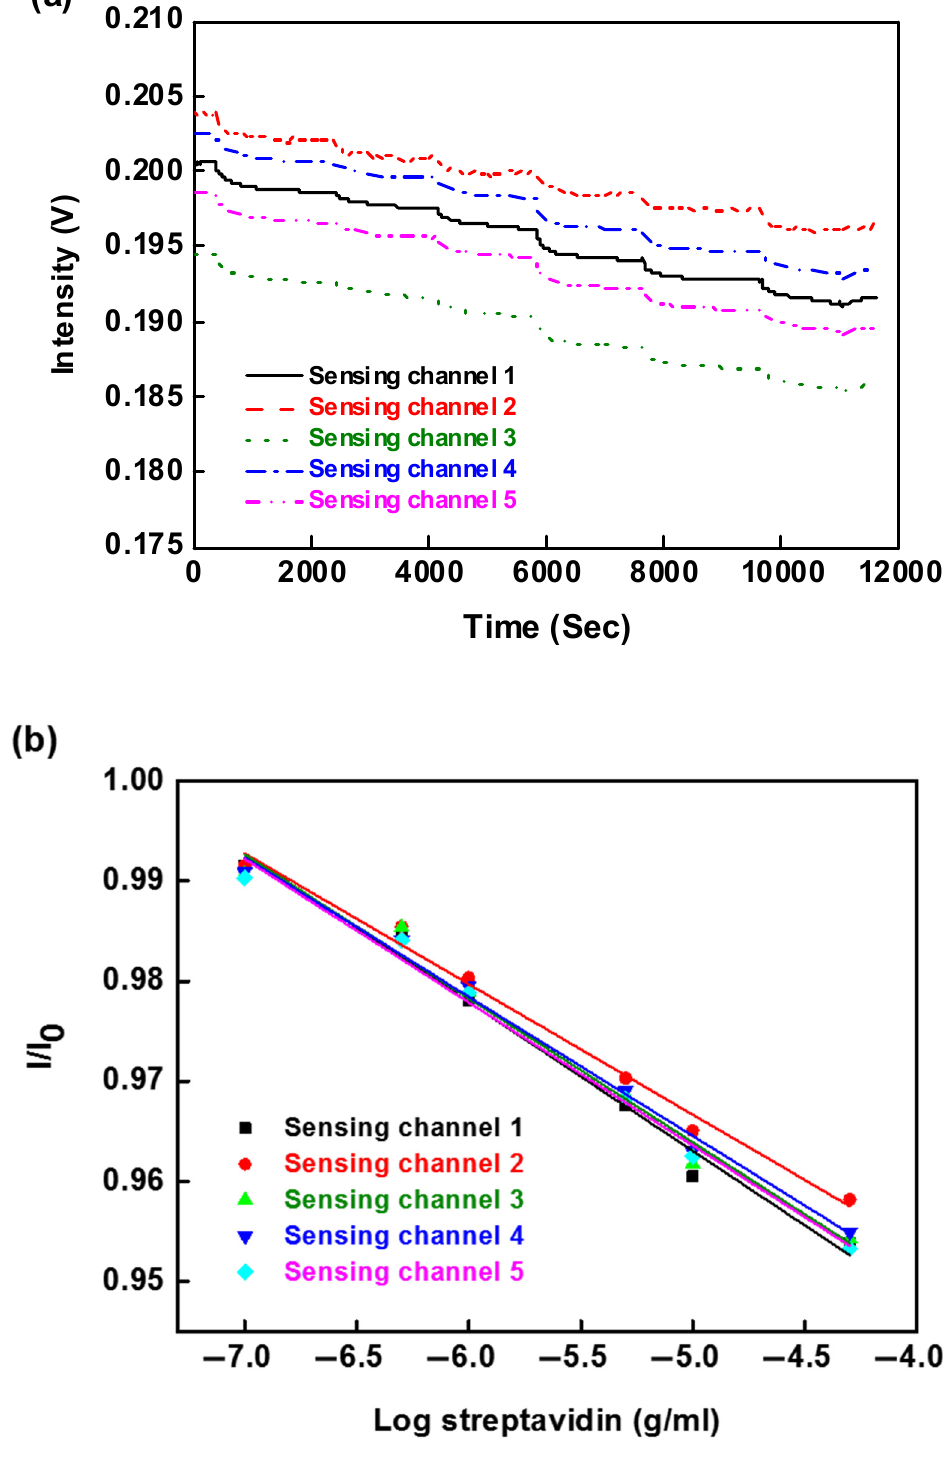
Figure 8. ( a ) Simultaneous temporal responses of all sensing fibers in the multi-microchannel FOPPR sensor with serial injection of streptavidin solutions; ( b ) calibration graph obtained with the biotin-functionalized probes for streptavidin by the multi-microchannel sensing system.